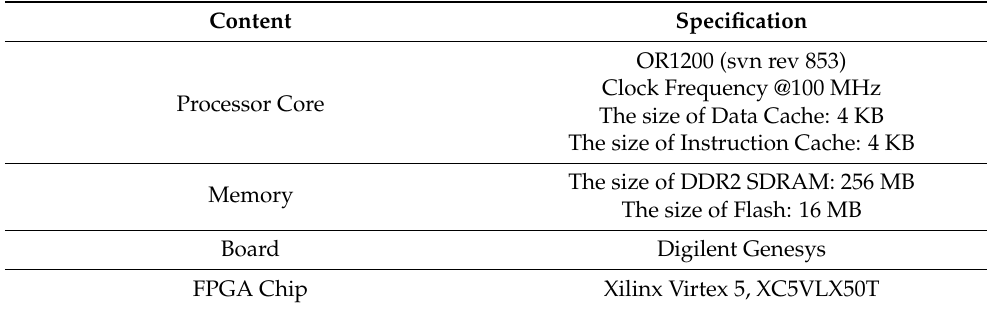
Table 3. The configuration of the